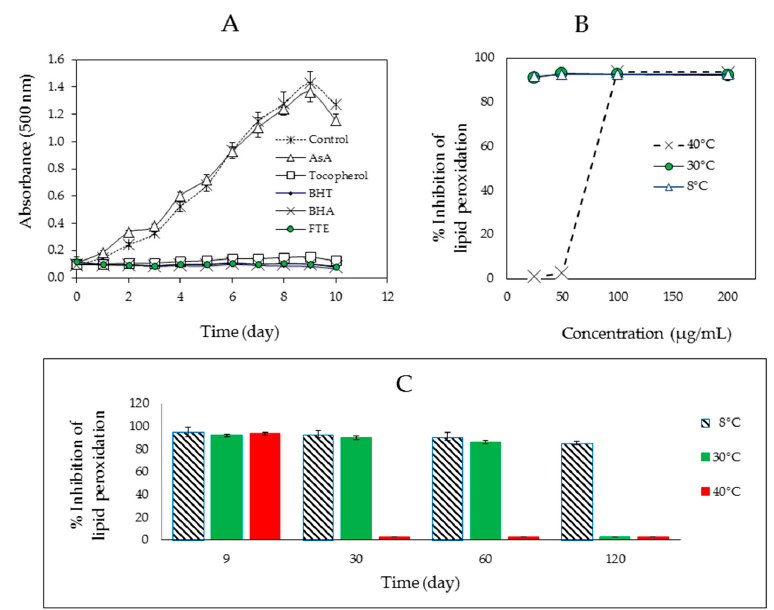
Figure 1. The effect of a methanolic extract of fresh tea leaves (FTE) and the positive references on the lipid peroxidation of a linoleic acid emulsion as measured by the formation of ferric thiocyanate. ( A ) Time course of linoleic acid peroxidation at 30 °C in the absence or presence of samples at a concentration of 100 µg/mL ( n = 2); ( B ) Percent inhibition of lipid peroxidation as a function of sample concentration on day 9 of peroxidation at various temperatures ( n = 2); ( C ) Percent inhibition of lipid peroxidation by the FTE (200 µg/mL) versus time (day) at various temperatures ( n = 2). (DPPH) Assay